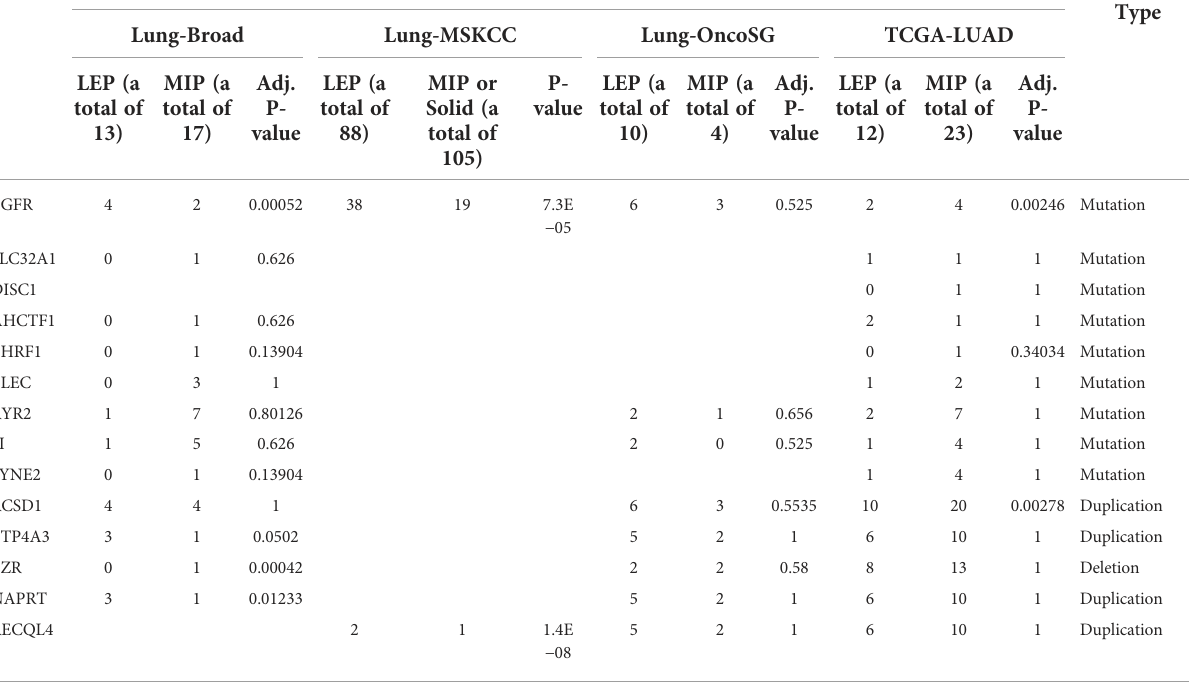
TABLE 2 Inspection on the alternation frequency of genes exhibited subtype-speci fi c alternations using four public cohorts.